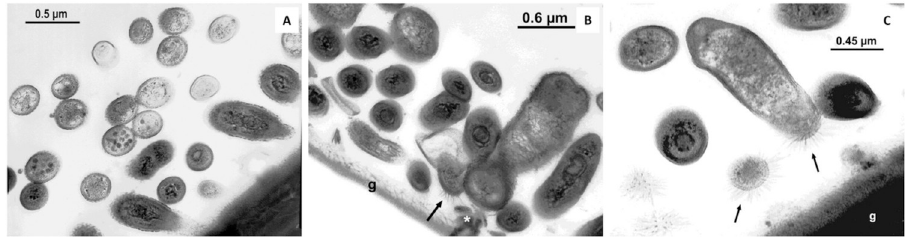
Fig 4. Prokaryotes morphology on the outer surface of the gill lamellae in Tubuca urvillei . Gill lamellae surface is indicated by ‘g’. Dense multilayers of bacteria are observed on the gill lamellae surface ( A, B ). The presence of pili and electron-dense filaments from the prokaryote cells to the gill lamellae surface is indicated by the arrow ( B, C ).